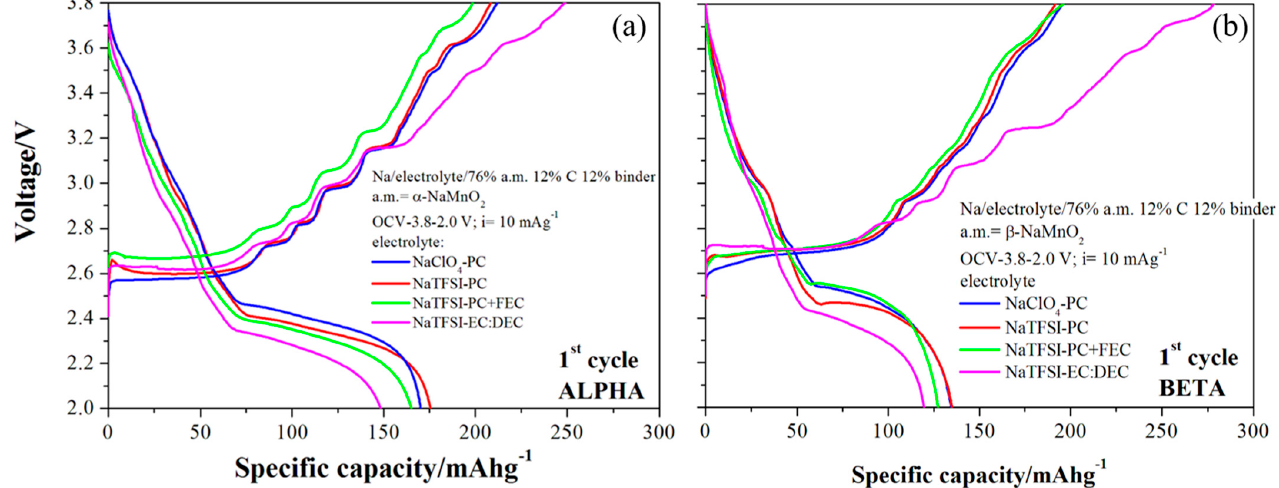
Figure 7. Charge/discharge voltage profiles during galvanostatic tests of the ( a ) α -NaMnO 2 and ( b ) β -NaMnO 2 phases.